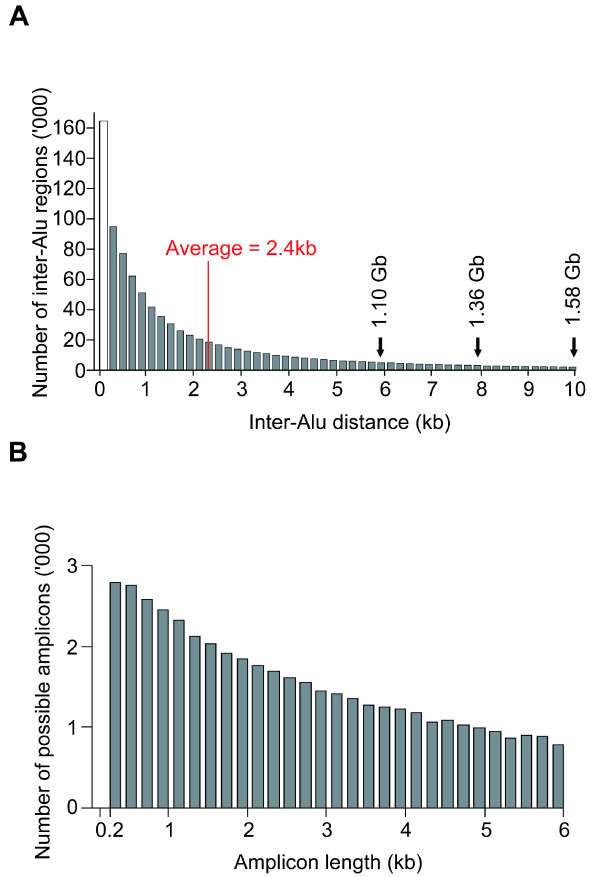
Inter-Alu sequences in the human genome. (A) Length distribution of inter-Alu distances between two adjacent Alu-transposons in the reference human genome. Heights of bars represent number of adjacent Alu pairs in the human genome at different inter-Alu distances. Subtraction of empty column at < 200 bp representing short inter-Alu sequences that were removed from analysis during library construction for next generation sequencing leaves the solid columns of inter-Alu sequences of varying lengths capturable from the genome. The total sum of the solid columns up to an inter-Alu distance of 6 kb, 8 kb or 10 kb equals 1.10 Gb, 1.36 Gb or 1.58 Gb, respectively. (B) Inter-Alu sequences of 0.2-6.0 kb in length that are in principle capturable by the three Alu-consensual primers AluY278T18, AluY66H21 and R12A/267. Such capturable amplicons amount to ~14 Mb if no mismatch is allowed between the consensual primers and template sequences, or ~106 Mb if one mismatch is allowed per primer. The graph shows the length distribution of the latter 106 Mb.